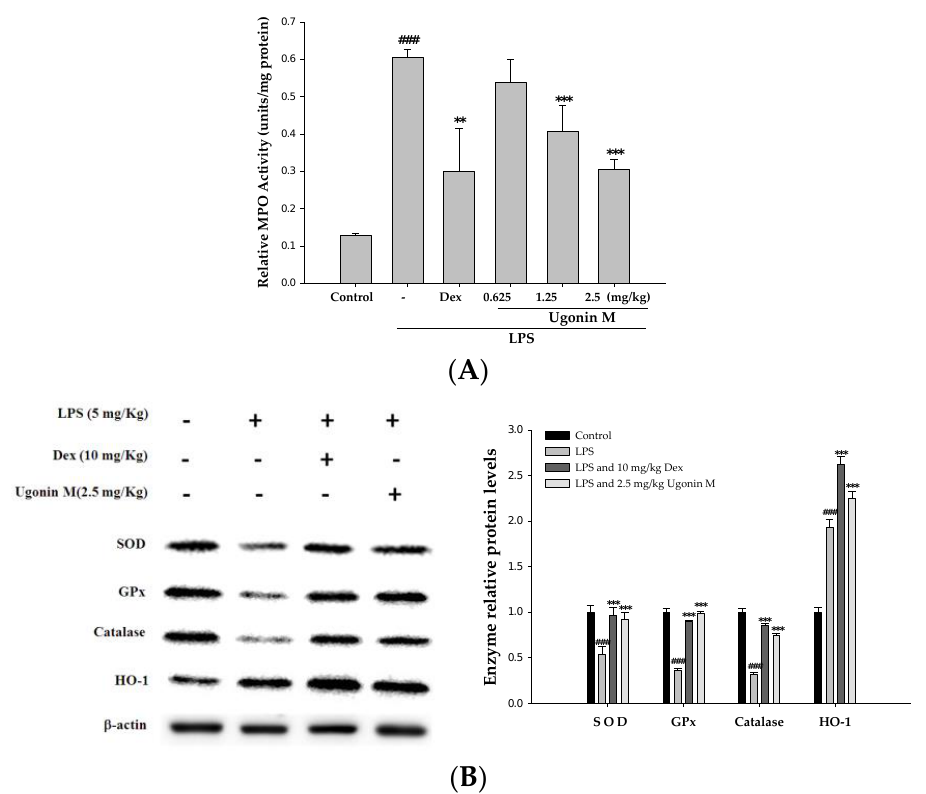
Figure 7. Effects of Ugonin M on: ( A ) MPO activity; and ( B ) antioxidative enzyme expression (SOD, GPx, catalase, and HO-1) in lungs from mice with ALI. Tissue homogenates were prepared and subjected to Western blotting. Data represent the mean ± S.D. for three different experiments performed in triplicate. ### p < 0.001 was compared with a sample of the control group (One-way ANOVA followed by Scheffe’s multiple range tests). ** p < 0.01 and *** p < 0.001 were compared with the LPS-only group.